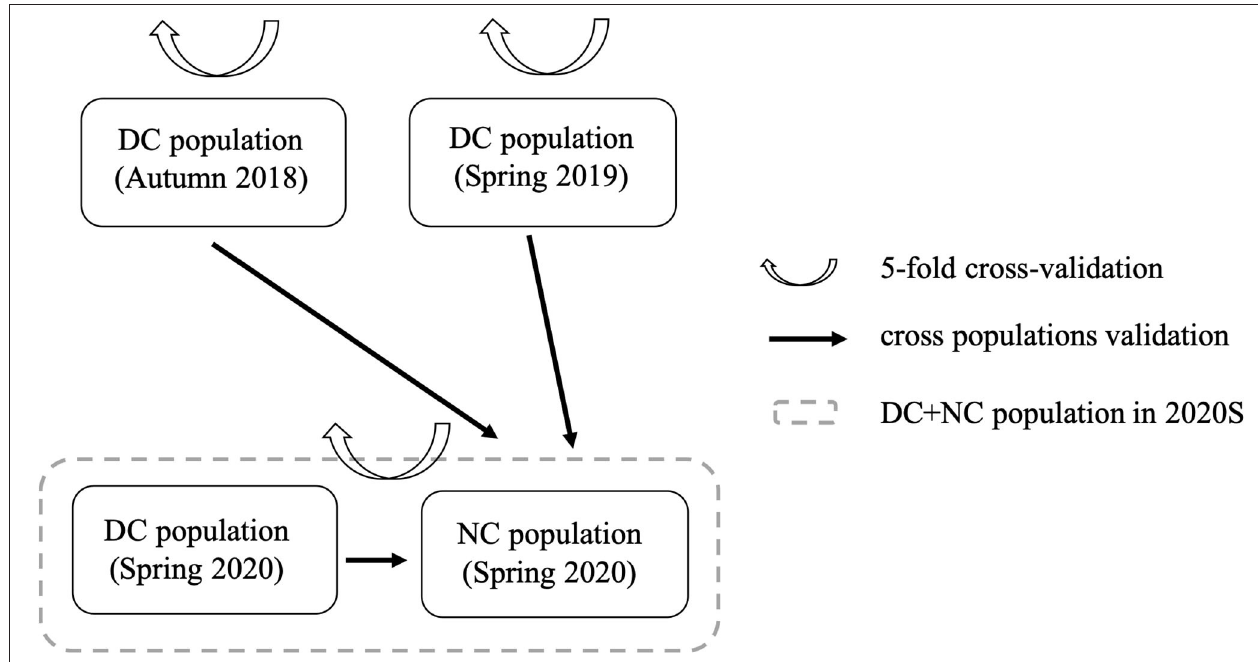
FIGURE 1 | Two model validation strategies for analysis. DC, diallel cross population; NC, NCII